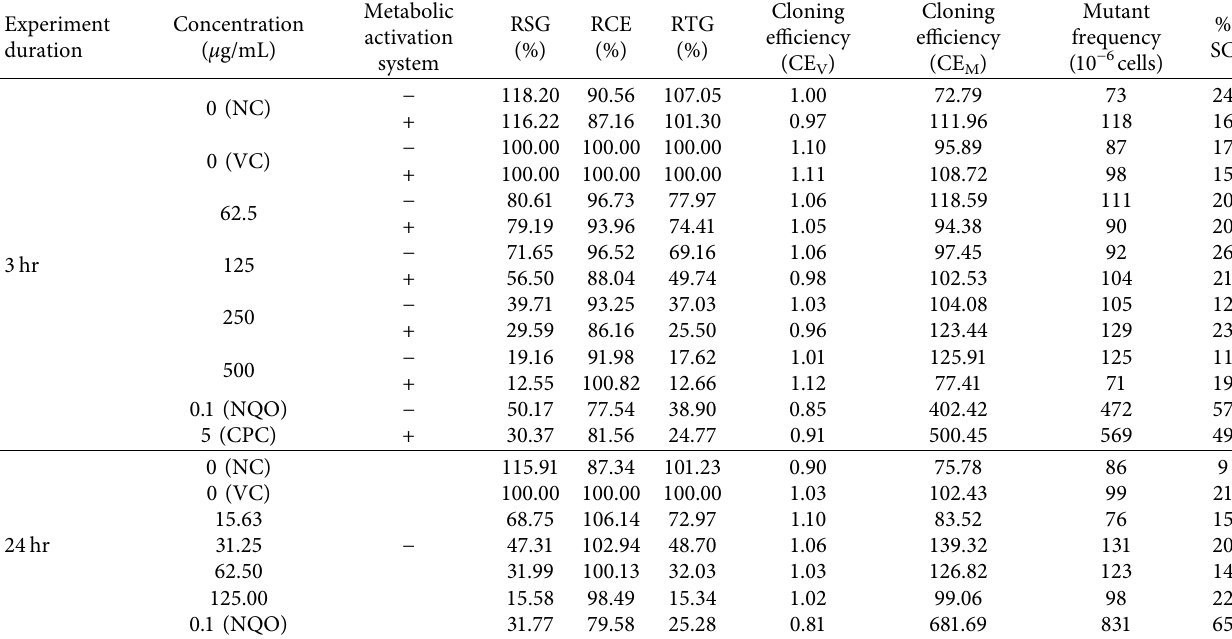
Table 12: Cytotoxicity and mutagenicity of LN18178 in mouse lymphoma cells, L5178Y TK +/ − Experiment